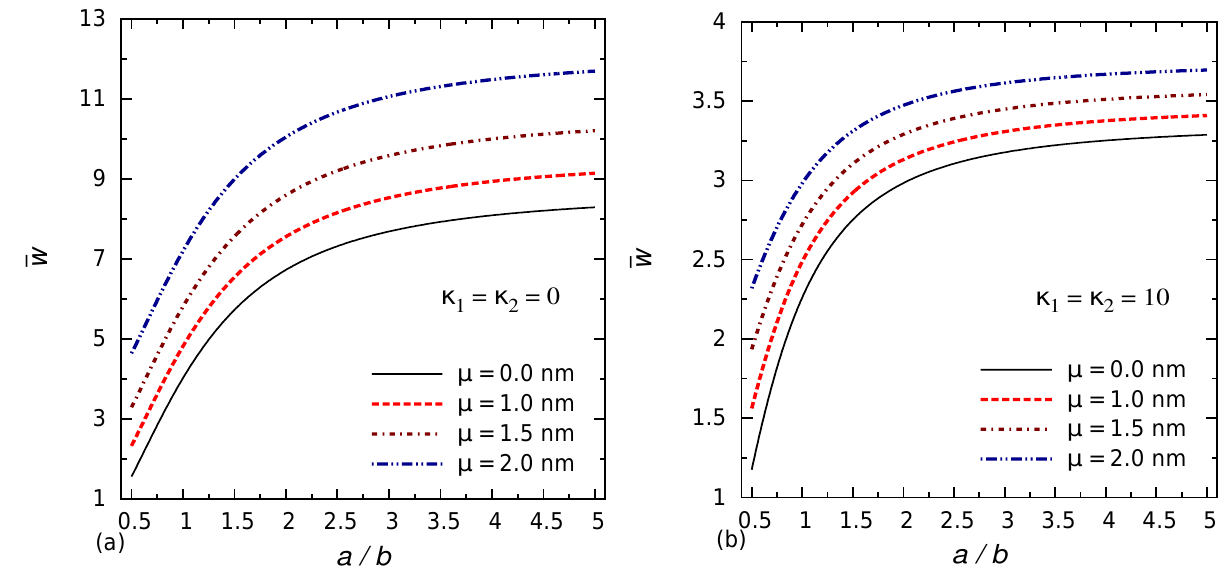
Figure 5. Effect of the nonlocal coefficient µ on the deflection ¯ w of the FG nanoplate varsus aspect ratio a / b ( a ) κ 1 = κ 2 = 0 and ( b ) κ 1 = κ 2 = 10 ( z / h = 0, a / h = 10, t 2 = t 3 = 50 ) .